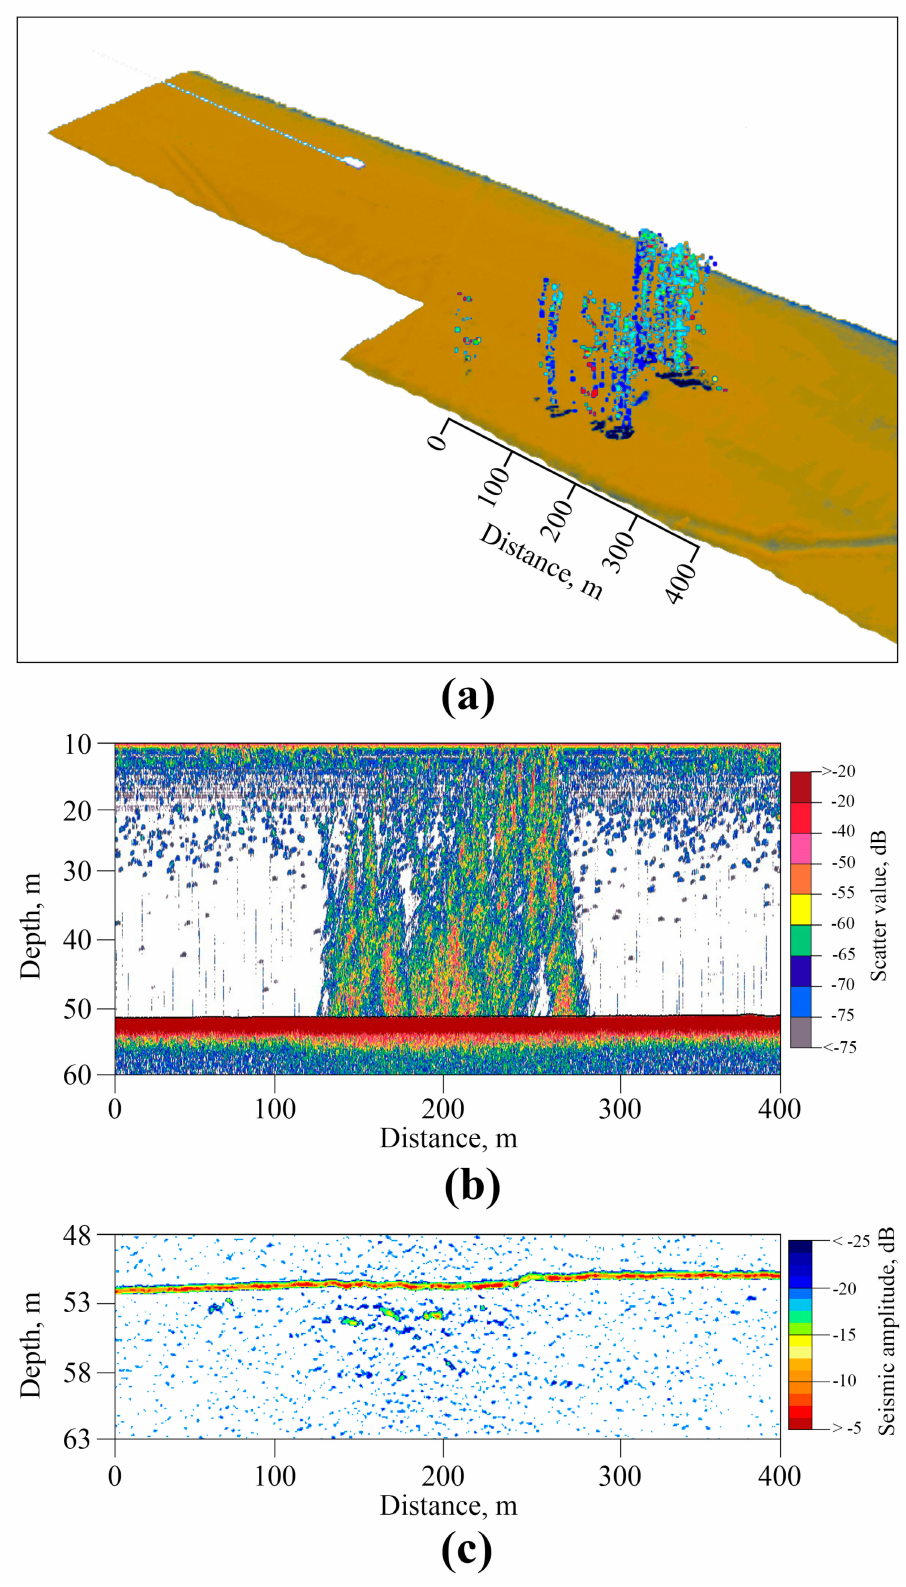
Figure 9. Multibeam ( a ), single beam ( b ), and SBP data ( c ) were obtained in the Laptev Sea from the same